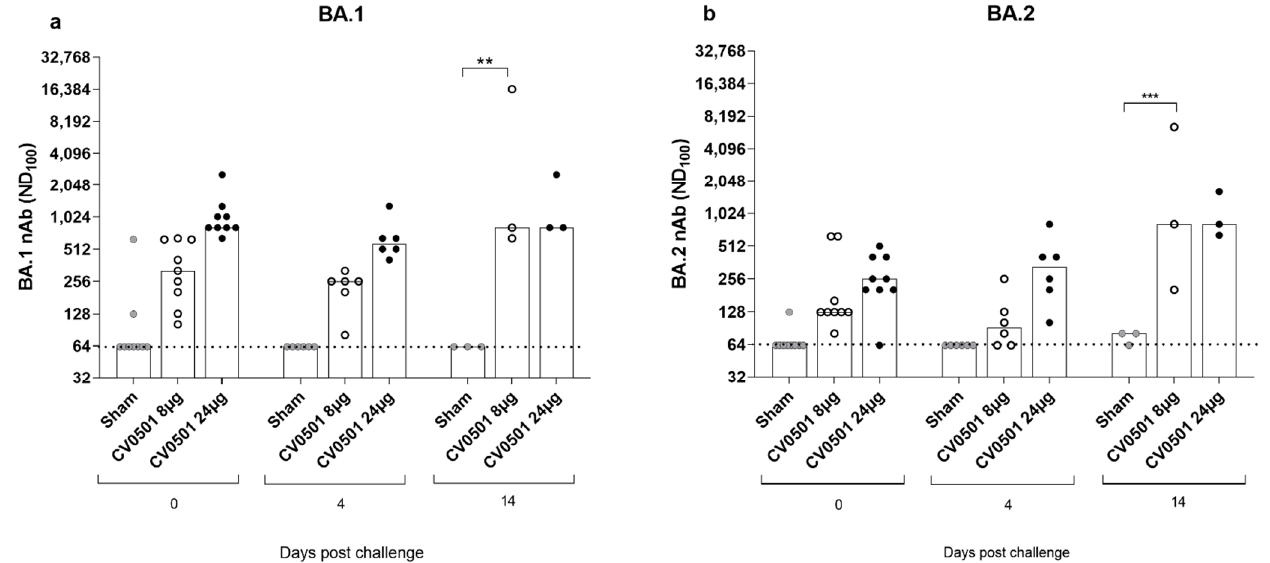
Figure 7. Significant induction of nAb against BA.1 and BA.2 Omicron variants observed after CV0501 vaccination. Hamsters ( n = 9/group) were immunized on Days 0 and 28 with 8 µ g or 24 µ g doses of CV0501 (white and black circles respectively) or 0.9% NaCl (sham controls) (grey circles) and challenged on Day 56 with Omicron BA.2 (10 5 TCID 50 /animal administered i.n. at 0.05 mL per nostril). nAbs against BA.1 ( a ) and BA.2 ( b ) were assessed in sera collected on Days 0 and 4 (6 animals/groups) or Day 14 (3 animals/groups) post-challenge. Virus nAb titers expressed as the neutralizing dose (ND) 100 of the sera. Each dot represents an individual animal, and the bars represent the median value of the group at the various time points. The horizontal dotted lines indicate the lower limit of detection of the assay. Statistical analysis was performed using two-way-ANOVA and Dunnett’s Test for multiple comparison. ** p < 0.01, *** p < 0.001.